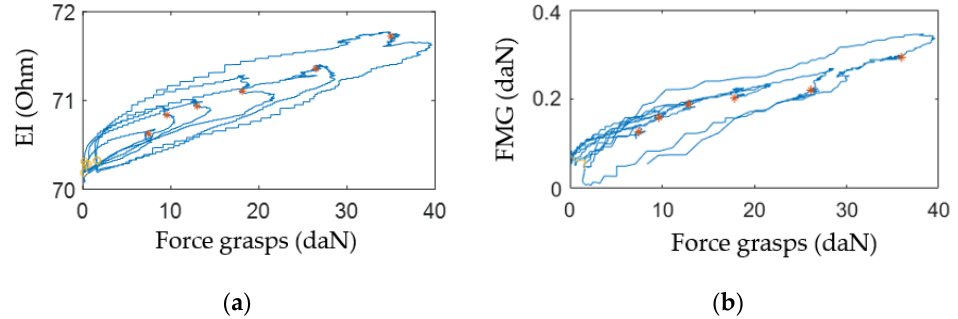
Figure 13. Change of EI (a) and FMG (b) signals depending on force grasps of the isometric grasping stand recorded with the sensor system placed at the projection of the extensor muscles.